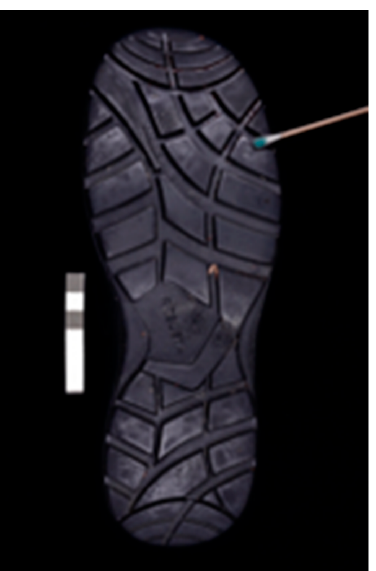
Figure 5. Footprint of the shoe used in the T-shirt under inspection.